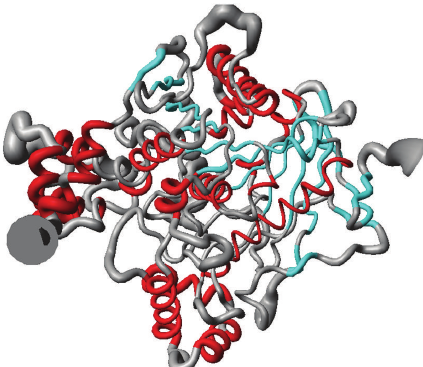
Figure 5: Illustration of the spatial RMSD of compound 2 inside AChE.